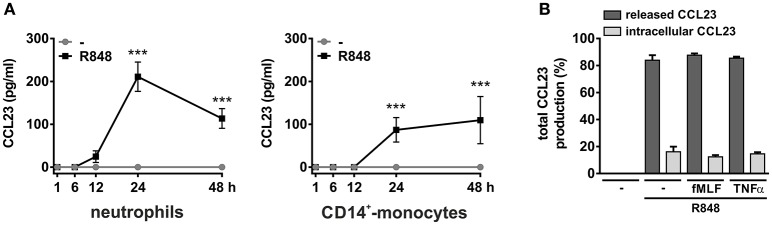
Production of CCL23 by neutrophils and monocytes incubated with R848. Neutrophils and CD14+-monocytes were cultured at 5 × 106 cells/ml with or without 5 μM R848 for up to 48 h to evaluate their capacity to produce and release CCL23, as detected by ELISA (n = 4–19) (A). In (B), neutrophils were cultured with or without 5 μM R848 for 24 h and then further incubated for 4 h with or without 10 nM fMLF or 10 ng/ml TNFα to evaluate released and cell-associated CCL23 (n = 4). Asterisks stand for significant increases: ***P < 0.001 by two-way ANOVA followed by Bonferroni's post-test.